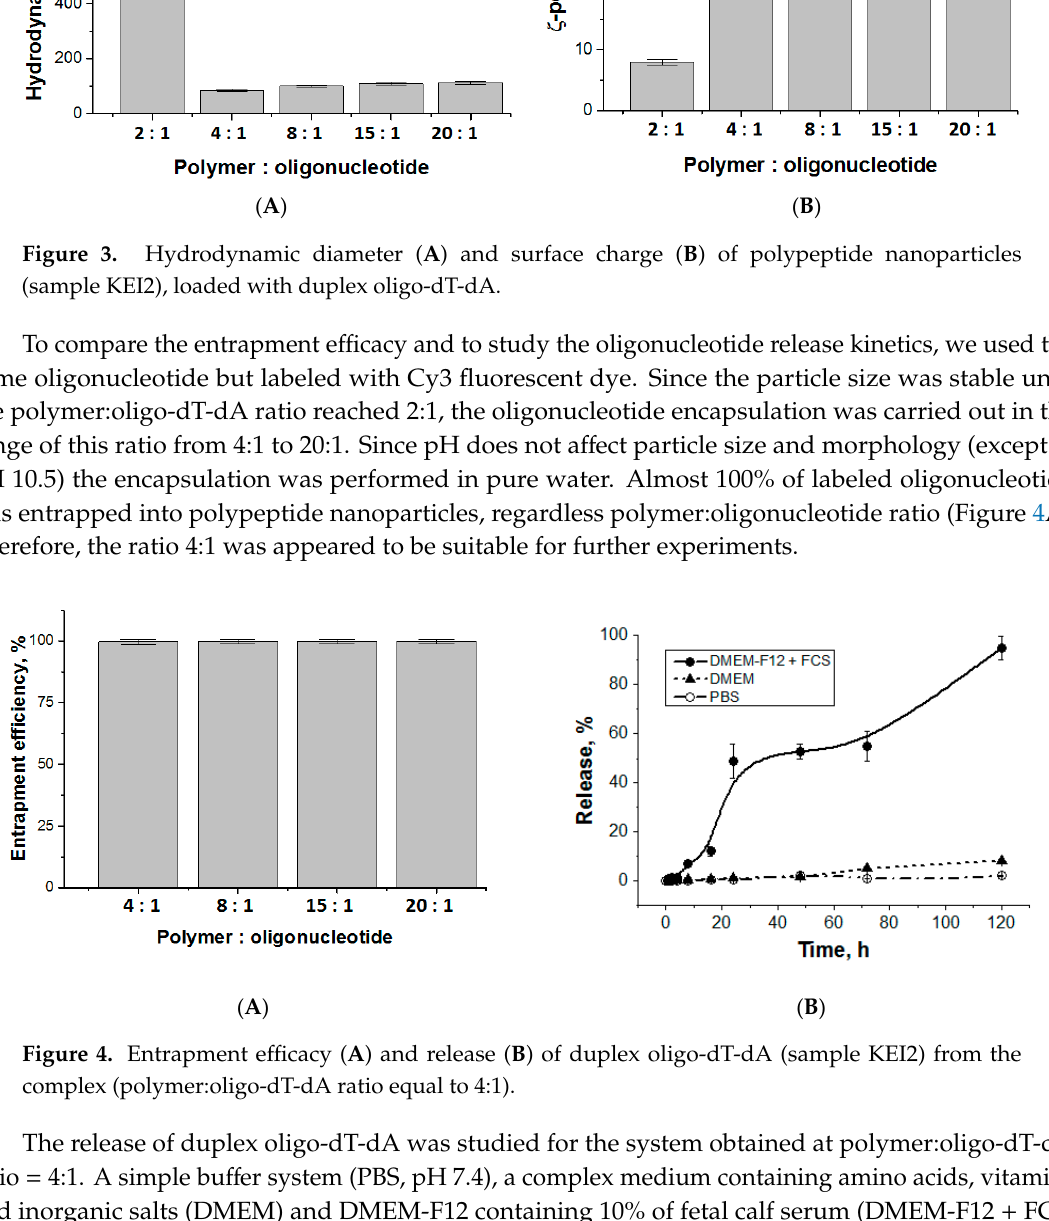
Figure 4. Entrapment efficacy ( A ) and release ( B ) of duplex oligo-dT-dA (sample KEI2) from the complex (polymer:oligo-dT-dA ratio equal to 4:1).